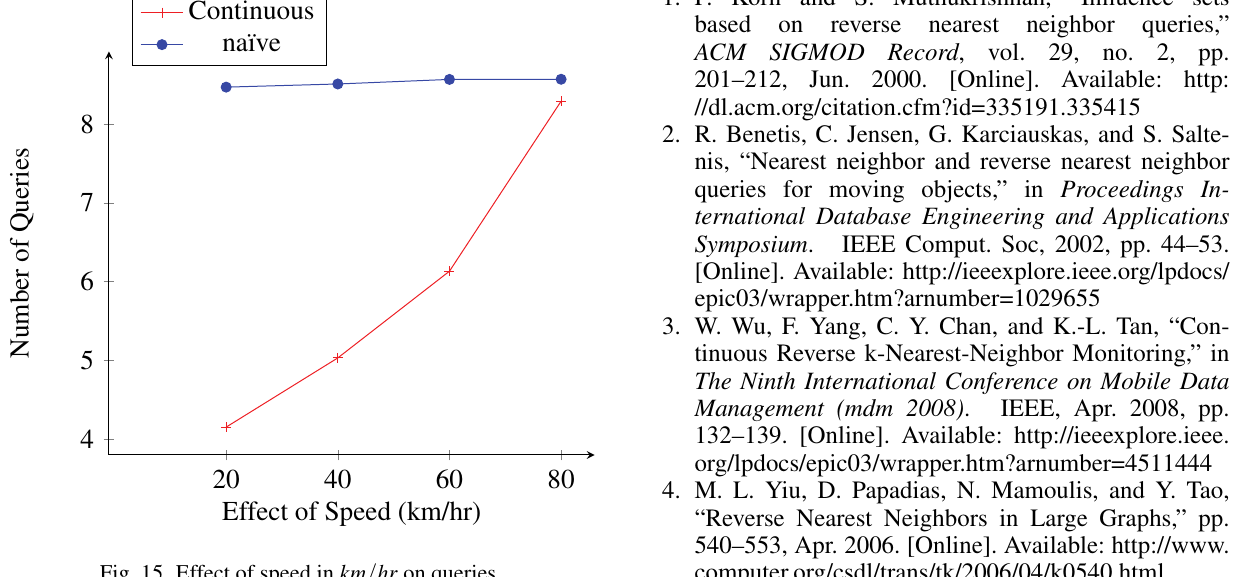
Fig. 15. Effect of speed in km / hr on